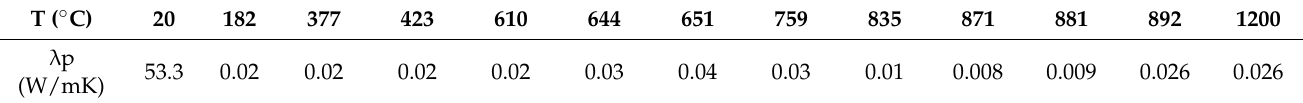
Table 3. Thermal conductivity of Intumescent Coating